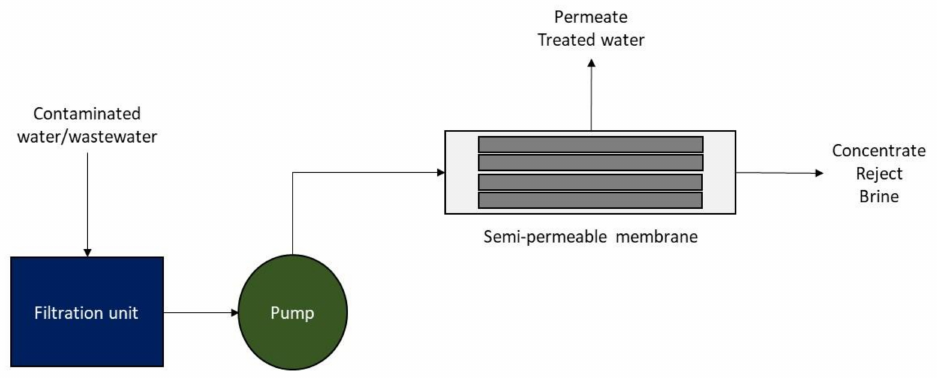
Figure 4. The layout of the general process involved in membrane filtration